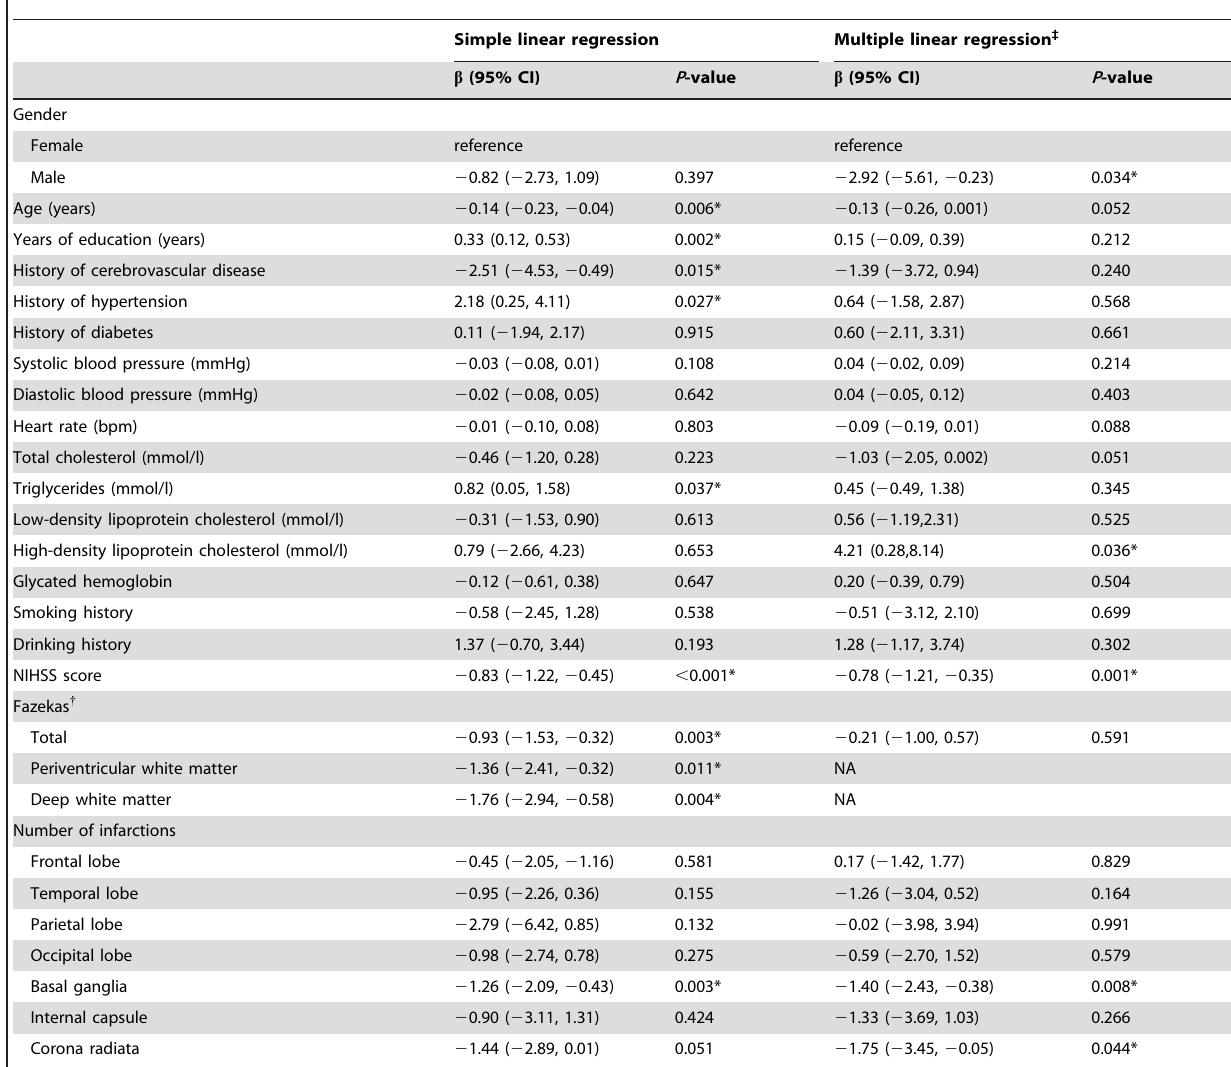
Table 3. Simple linear regression and multiple linear regression in the MDRS I/P score.